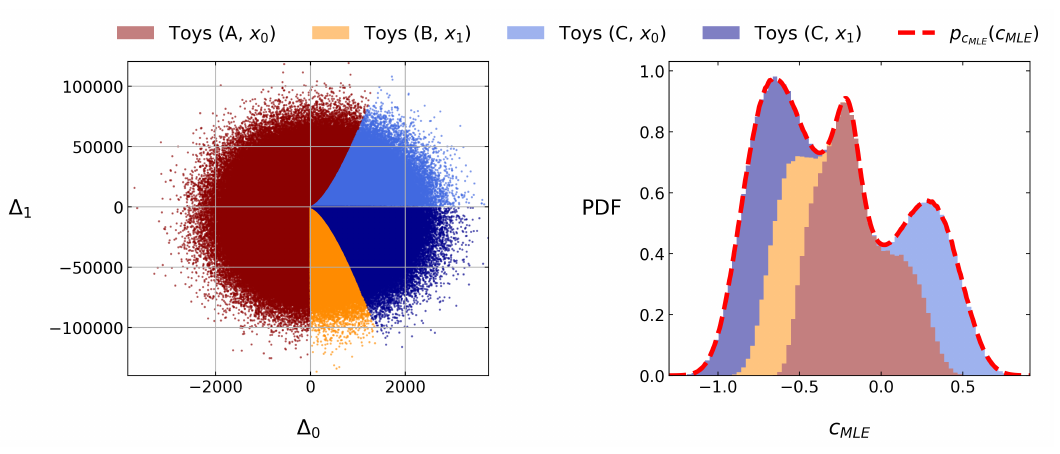
Figure 27: Left: scatter plot of toys in the ( ∆ of toys as a function of c